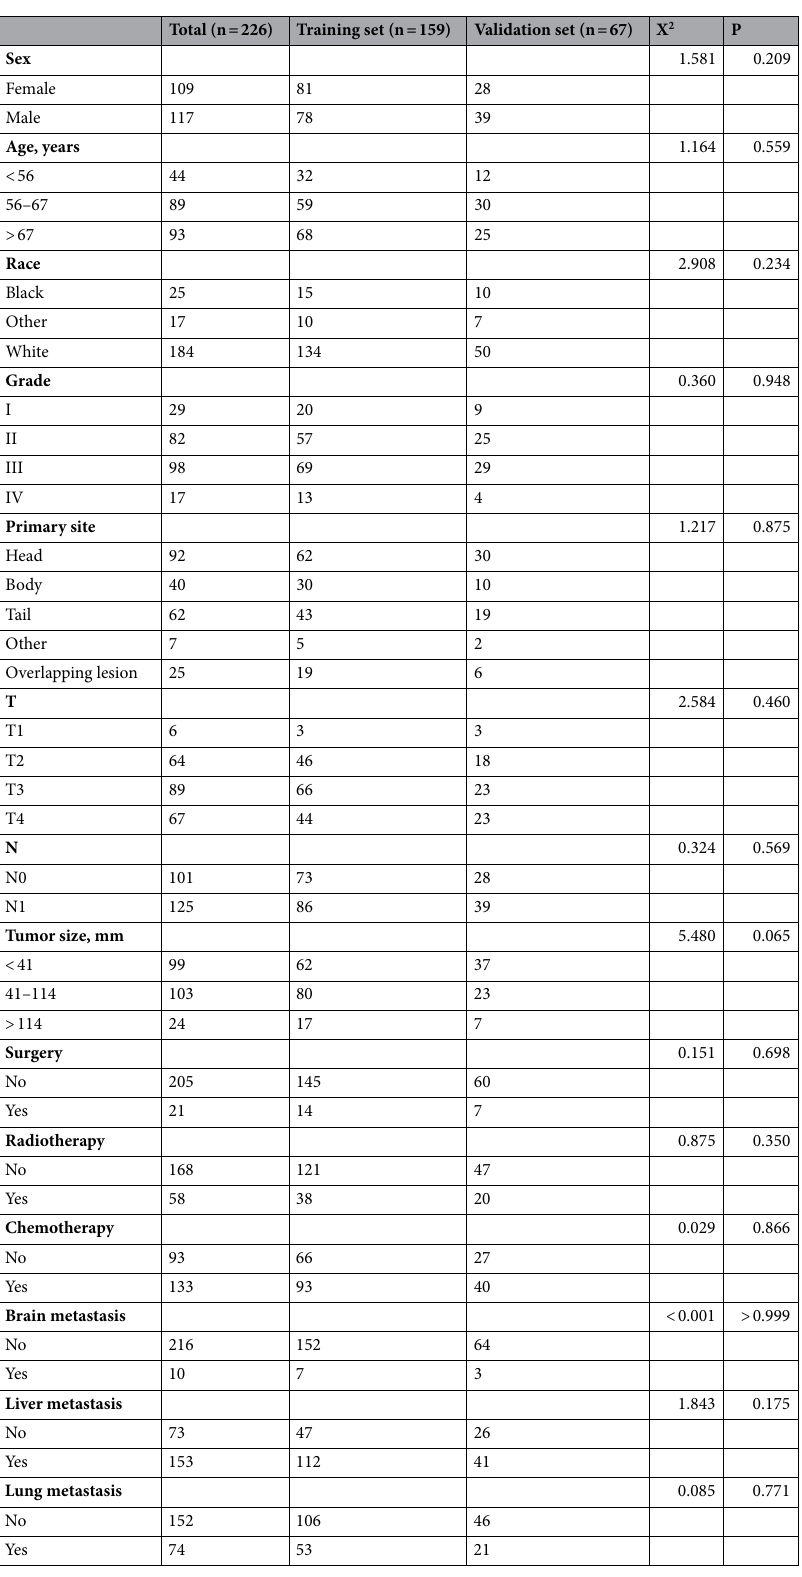
Table 3. Clinical characteristics of 226 PC patients with